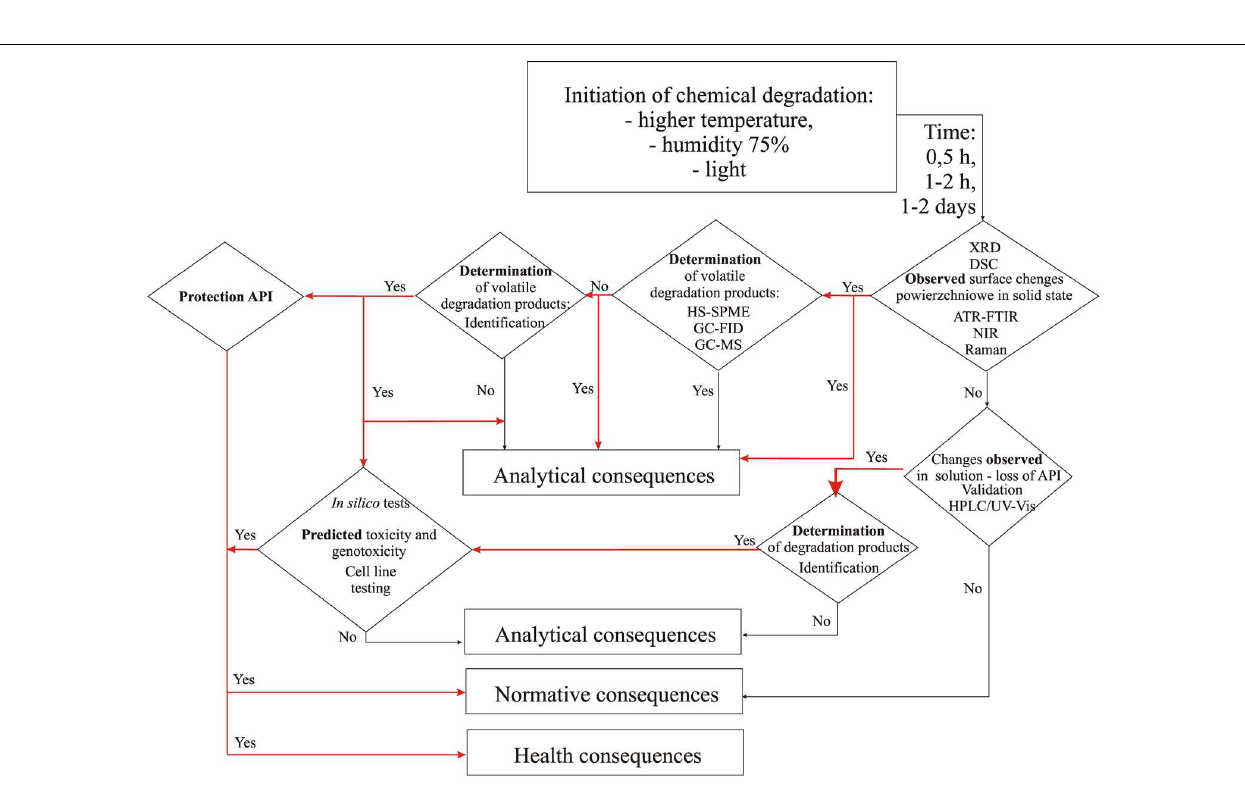
Frontiers in Pharmacology |